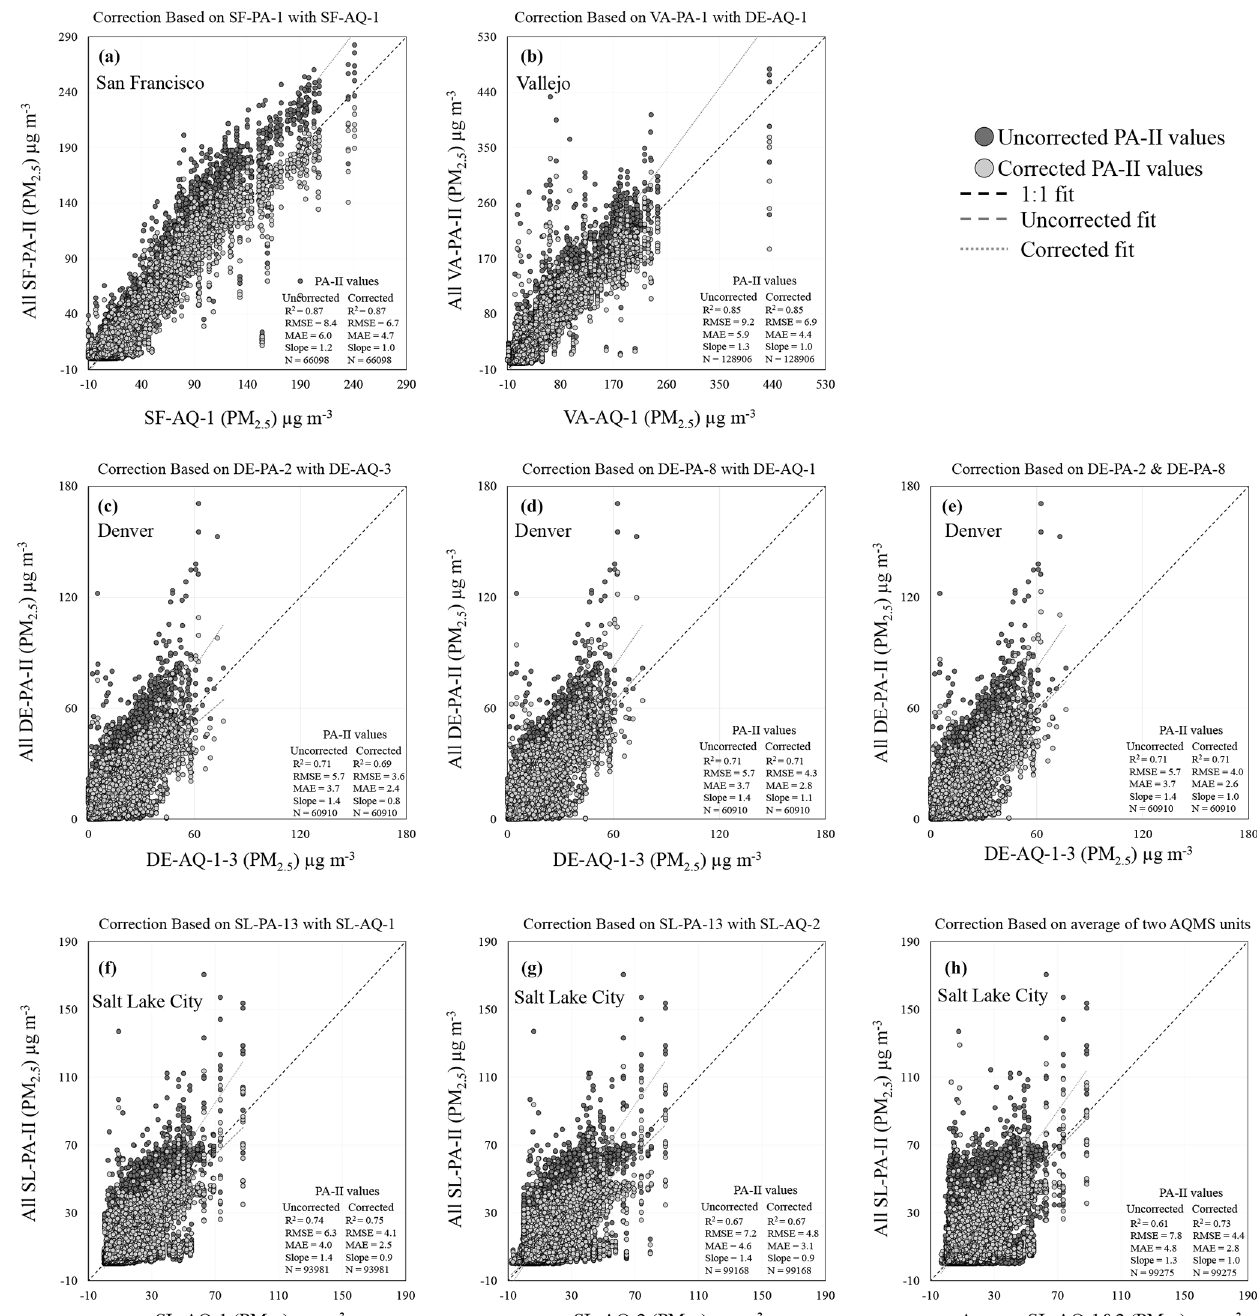
Figure 5. Comparison of hourly uncorrected PA-II (PM 2 . 5 ) values compared to nearest AQMS (PM 2 . 5 ) values (black) and corrected PA- II (PM 2 . 5 ) values compared to AQMS (PM 2 . 5 ) values (gray). Dashed lines represent a 1 : 1 line. Statistics of each case included the R 2 , RMSE, and MAE for the uncorrected and corrected (MLR) data. N represents the number of data points used in the MLR. Each figure represents corrections based on different MLR type: San Francisco (a) based on SF-PA-1 with SF-AQ-1 and Vallejo (b) based on VA-PA- 1 with DE-AQ-1. Different corrections were made for Denver (c–e) : DE-PA-2 with DE-AQ-3 (c) and DE-PA-8 with DE-AQ-1 (d) and combining DE-PA-2 with DE-AQ-3 and DE-PA-8 with DE-AQ-1 (e) . Different corrections were made for Salt Lake City (f–h) : based on SL-PA-13 with SL-AQ-1 (f) and SL-PA-13 with SL-AQ-2 (g) , and the MLR was based on SL-PA-13 with an average of both AQMS units (h)